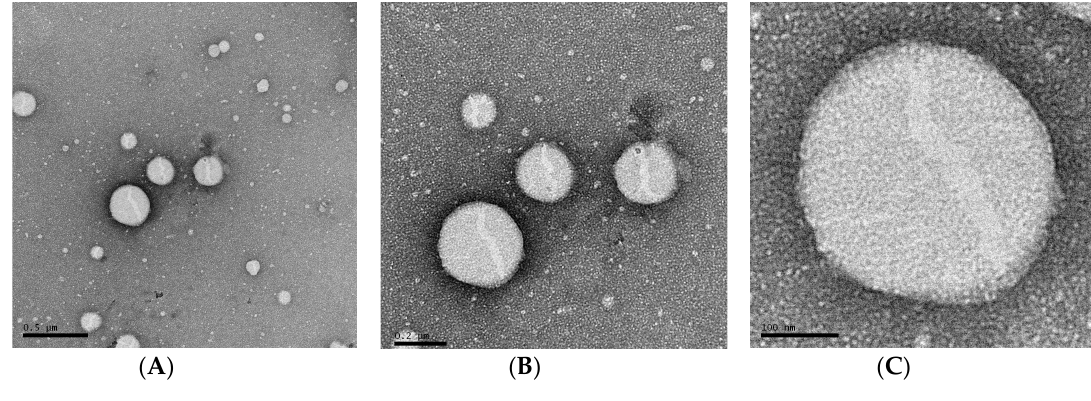
Figure 6. Morphological analysis by Transmission Electron Microscopy of Capt(0.5)-Zn(25)-MLNC-Fur(0.45), diluted in a proportion of 1:10 in MilliQ ® water ( v / v ), placed on a copper grid (400 mesh) coated with formvar-carbon (Electron Microscopy Sciences) and stained with 2% uranyl acetate aqueous solution. The samples were kept in a desiccator under vacuum until the analysis was performed at 80 kV [bars = 500 in ( A ), 200 in ( B ) and 100 nm in ( C )].